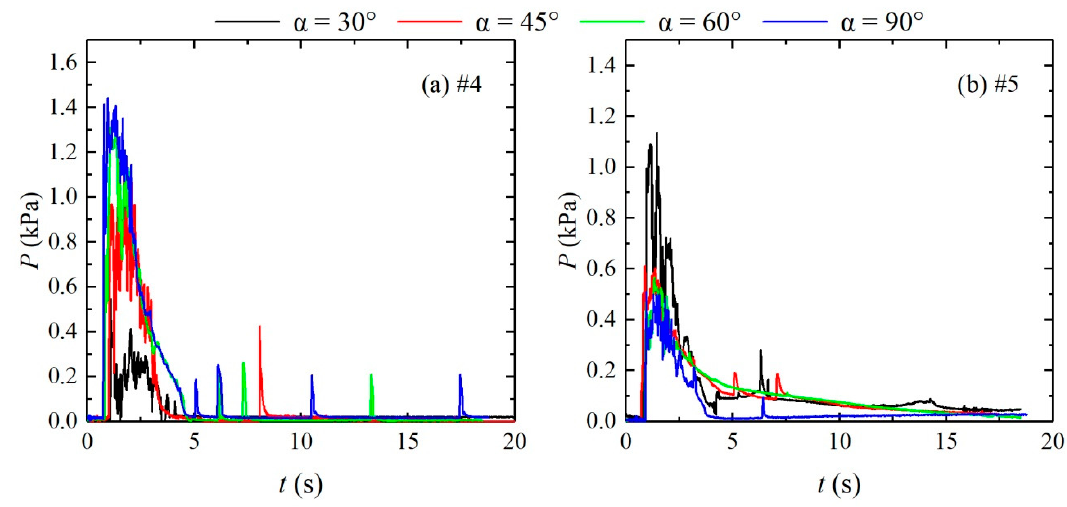
Figure 13. Pulsating pressure hydrographs at measuring points #4 and #5 of different configurations. ( a ): measuring points #4; ( b ): measuring points #5. Table 3. Peak pulsating pressures at different measuring points of different configurations. Confluence Angles Measuring Points 30